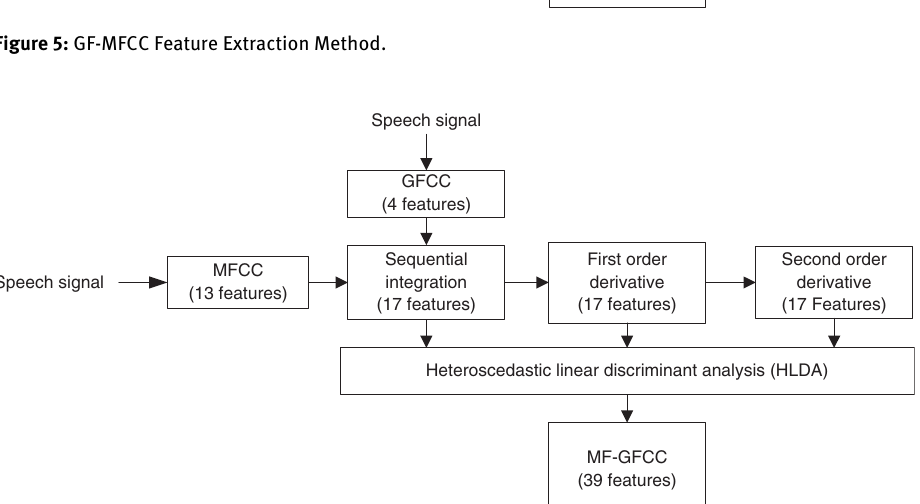
Figure 5: GF-MFCC Feature Extraction Method.